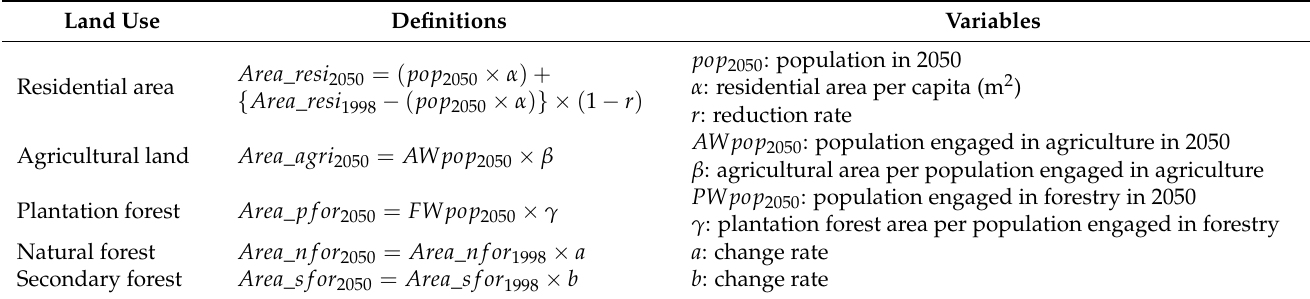
Table A1. Demand for each land use in the 2050 PANCES scenarios.